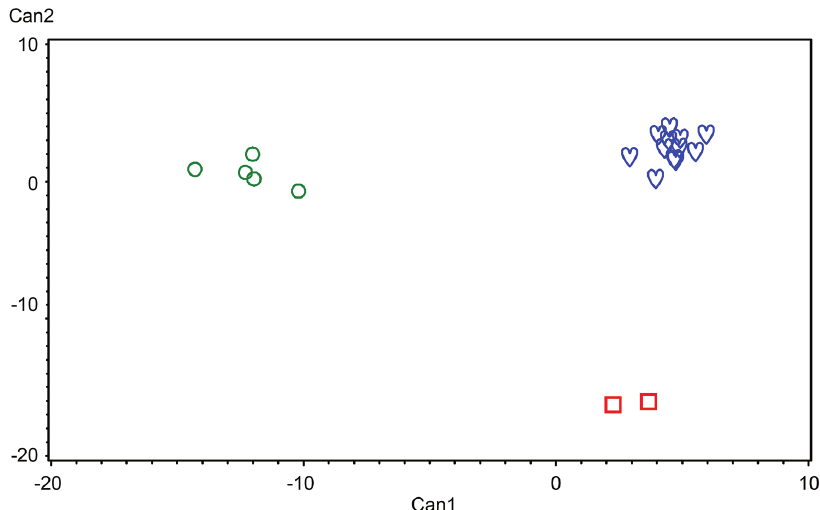
Figure 9. Canonical discriminant analysis (CDA 9) of three Lasiochernes species ( L . cretonatus : green cir- cles, L . jonicus : red squares and L . pilosus : blue hearts) based on 15 morphological characters for 19 adult specimens. For total canonical structure and the list of characters, see Table